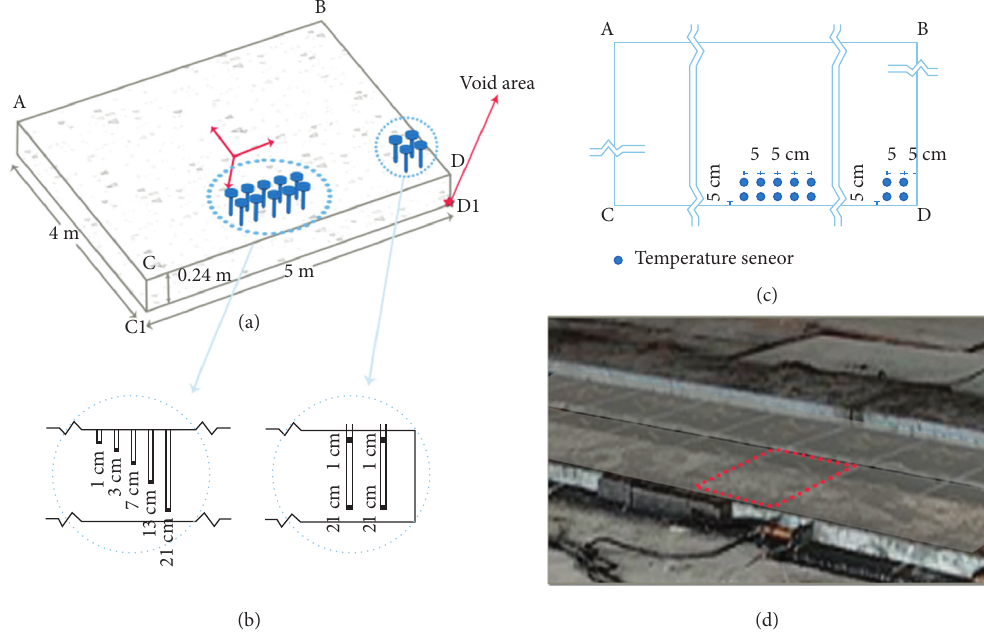
Figure 3: Positions of temperature sensors in the concrete slab: (a) perspective view, (b) front view, (c) top view, and (d) field picture of